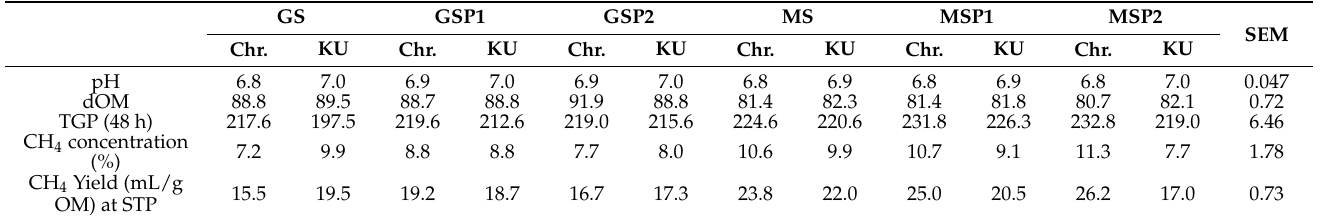
Table 2 . Laboratory results for pH, organic matter degradation (dOM), total gas production (TGP), CH 4 yield, and CH 4 concentration after 48 h of in-vitro fermentation of grass silage (GS) and maize silage (MS) with or without probiotic 1 (P1) or probiotic 2 (P2)